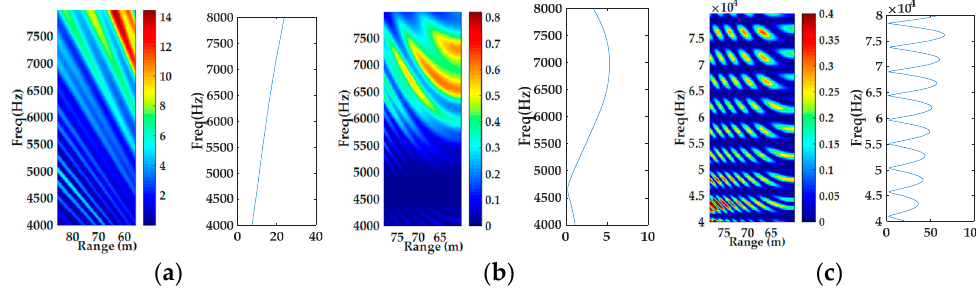
Figure 9. Comparison of interference striations and scattering function amplitudes: ( a ) the result of the monostatic configuration for 4 − 8 kHz; ( b ) the result of the bistatic configuration for 4 − 8 kHz; ( c ) the result of the bistatic configuration for 40 − 80 kHz .